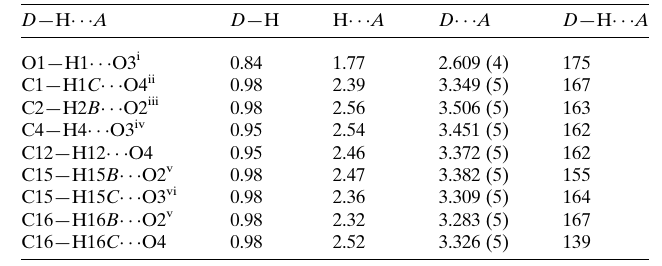
Table 1 Hydrogen-bond geometry (A˚ , (cid:5) ) for ( I ).